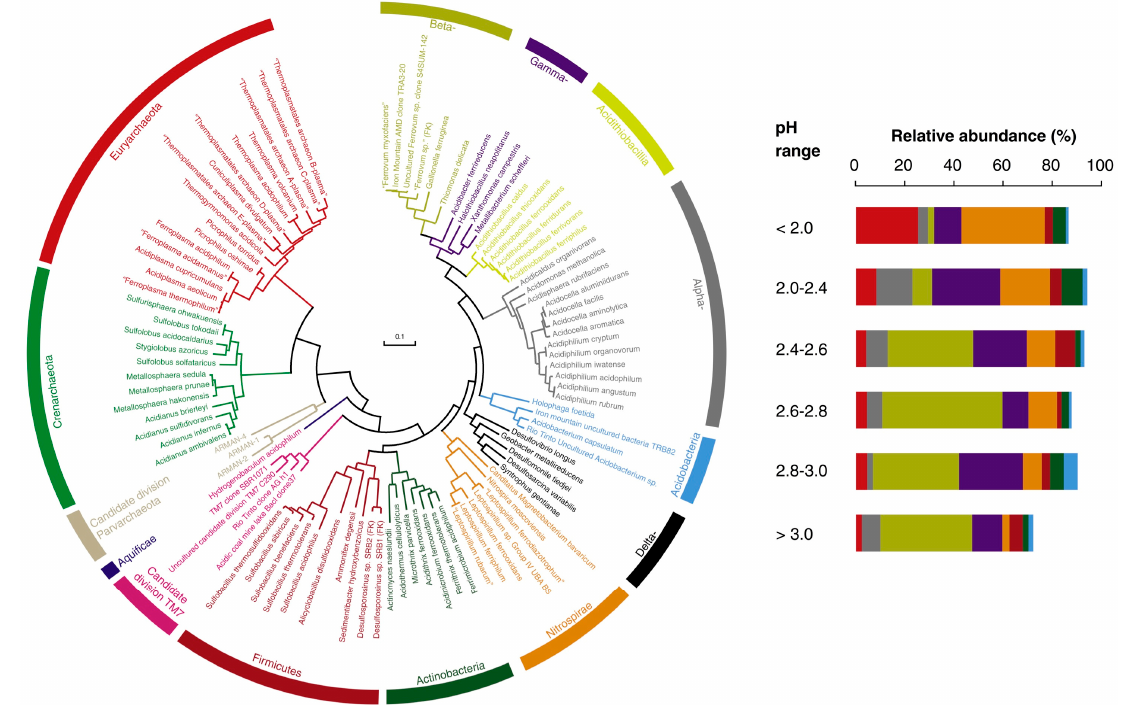
Figure 5. Prokaryotic microorganisms in AMD ecosystems insides acid solution, biofilms, and sediments and its distribution with different pH value ranges [134]. Reproduced with permission from Chen, L.X., Current Opinion in Biotechnology, Microbial communities, processes and function in acid mine drainage ecosystems; published by Elsevier,